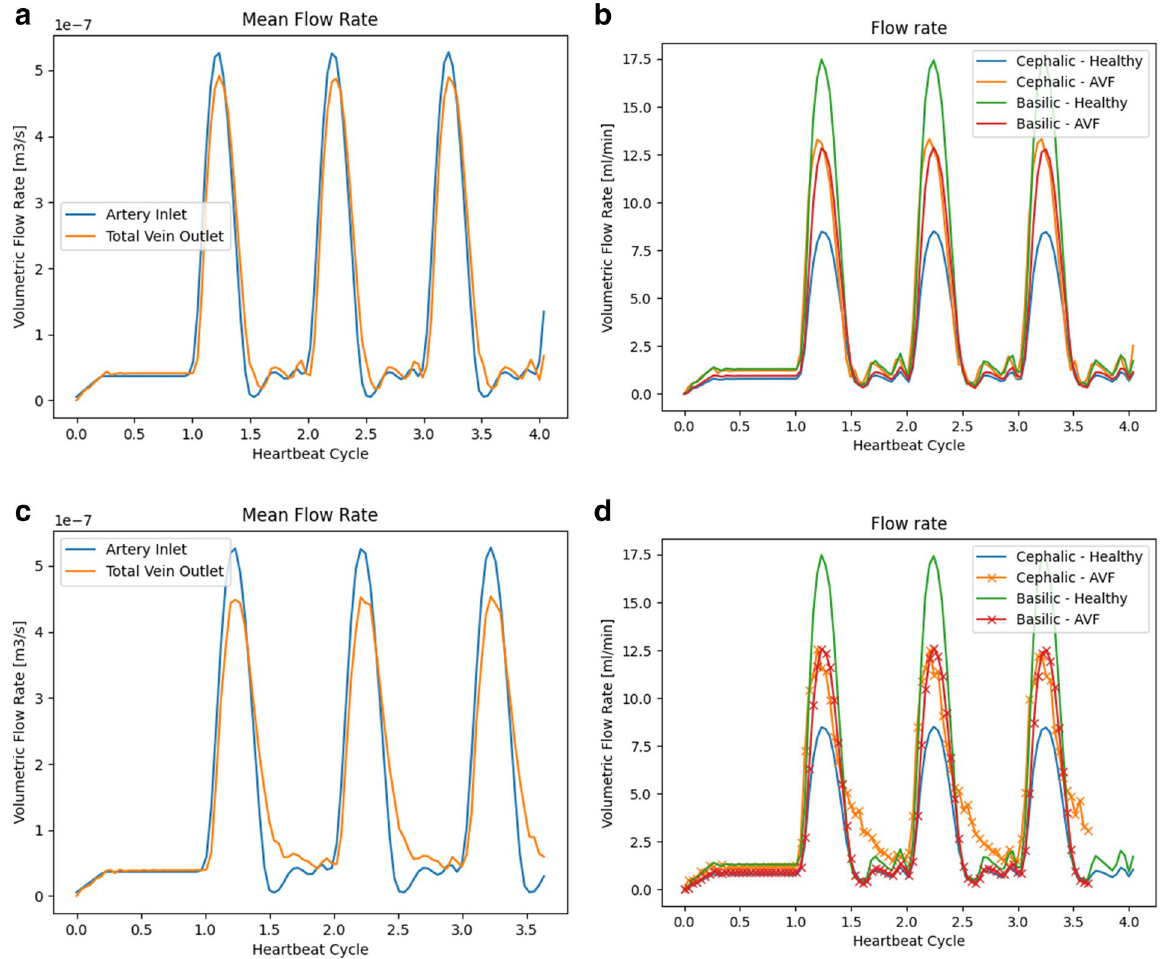
Figure 4. Flow rates through the forearm blood vessels with an arteriovenous fistula in its pre- and post- maturation states. Figures ( a ) and ( c ) indicate the total inlet and outlet flow of the system. Figures ( b ) and ( d ) compare flow exiting the major veins to that in the ‘healthy’